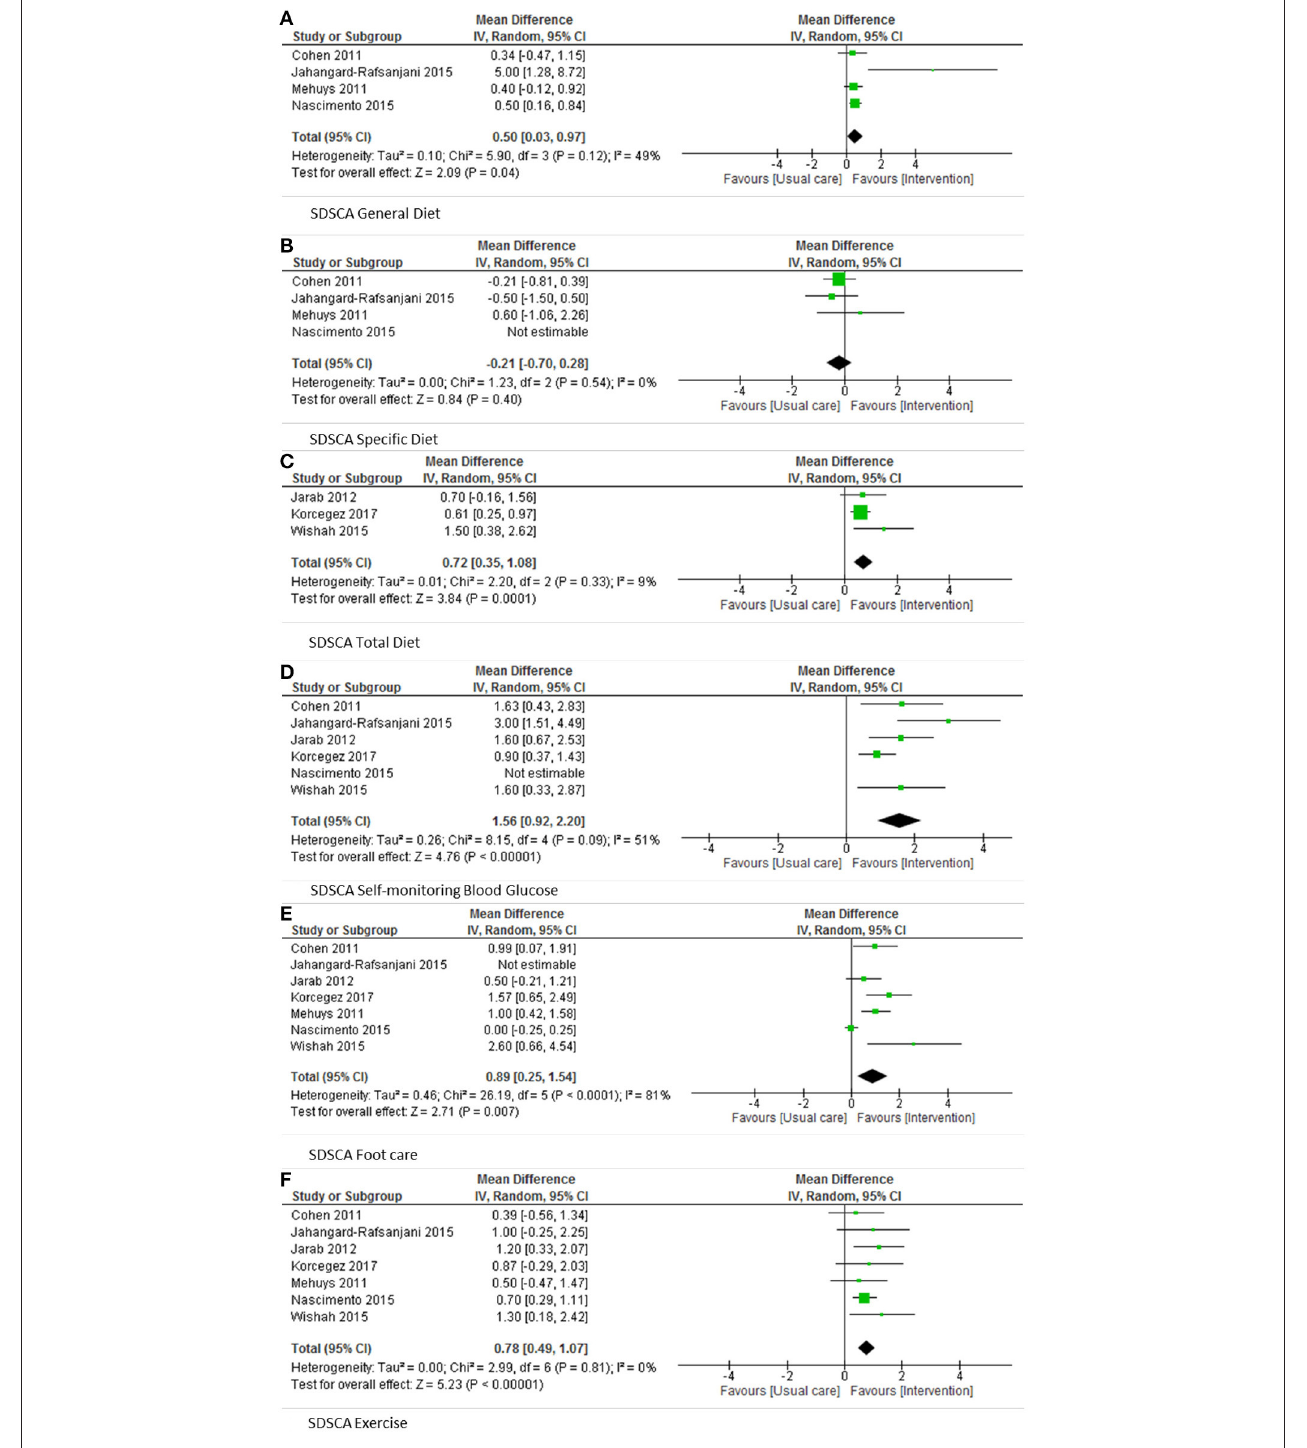
FIGURE 3 | Pooled results SDSCA